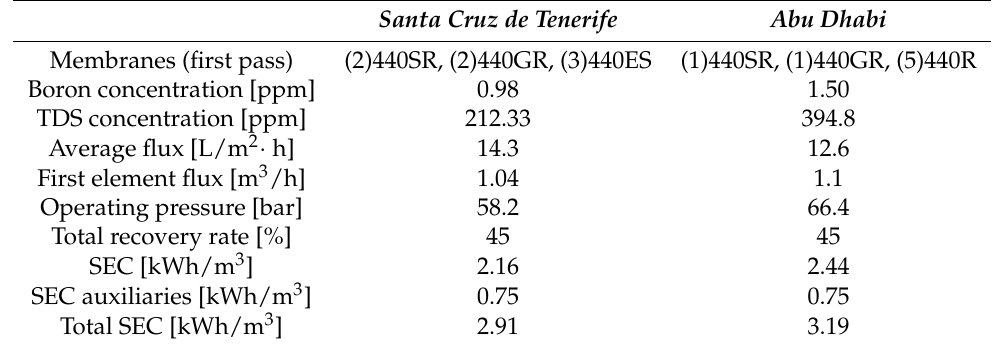
Table 4. Seawater reverse osmosis (SWRO) reference plant for Santa Cruz de Tenerife and Abu Dhabi . Santa Cruz de Tenerife Abu Dhabi Membranes (first